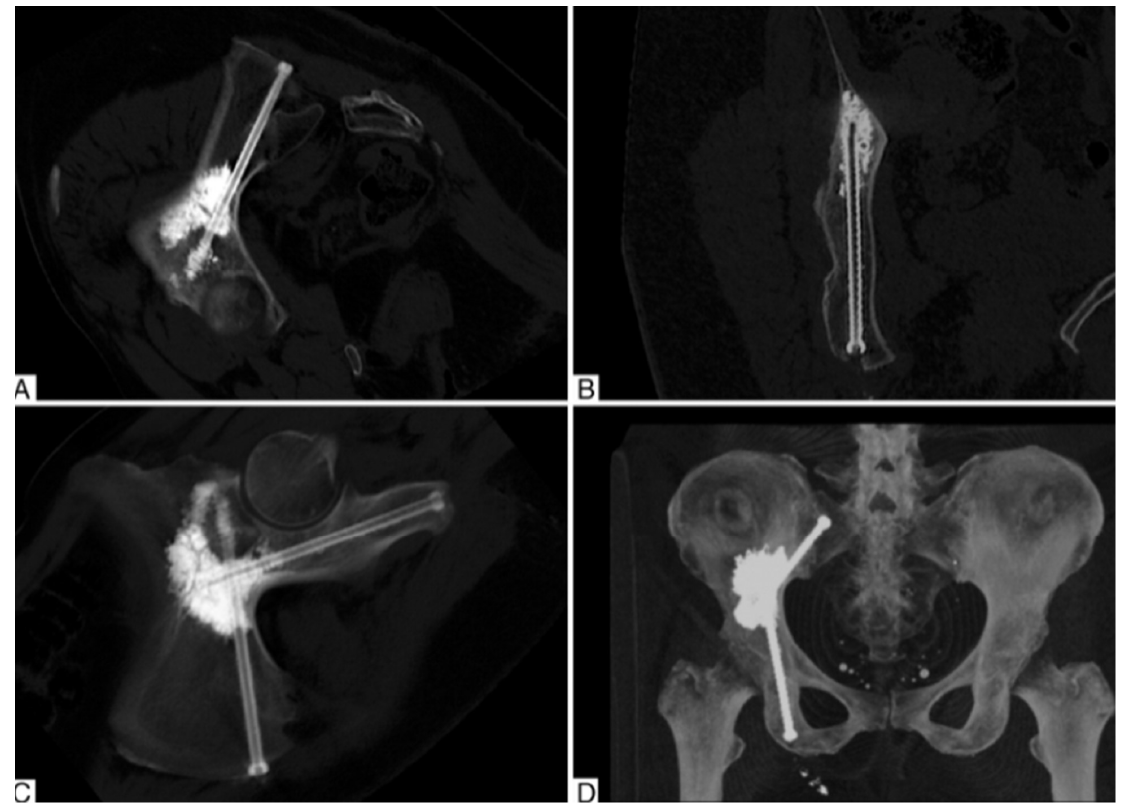
Figure 3. Computed tomography cuts ( A – C ) and 3D rendering ( D ) of transischiatic cementoplasty with percutaneous acetabular screw fixation. Image courtesy of Roux et al. [24].